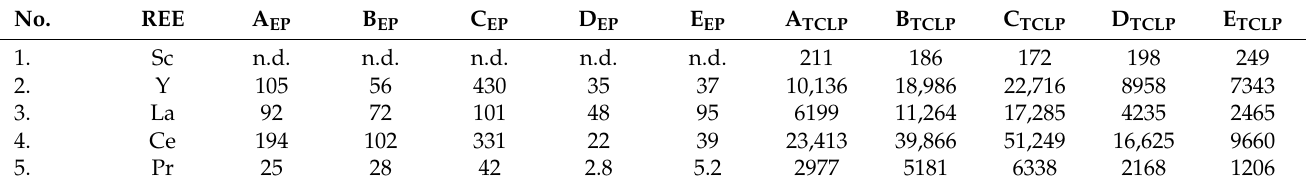
Table 4. REEs content (ng/L, except for Σ REEs is µ g/L) in CFA leachate (20 ÷ 1 L/S).